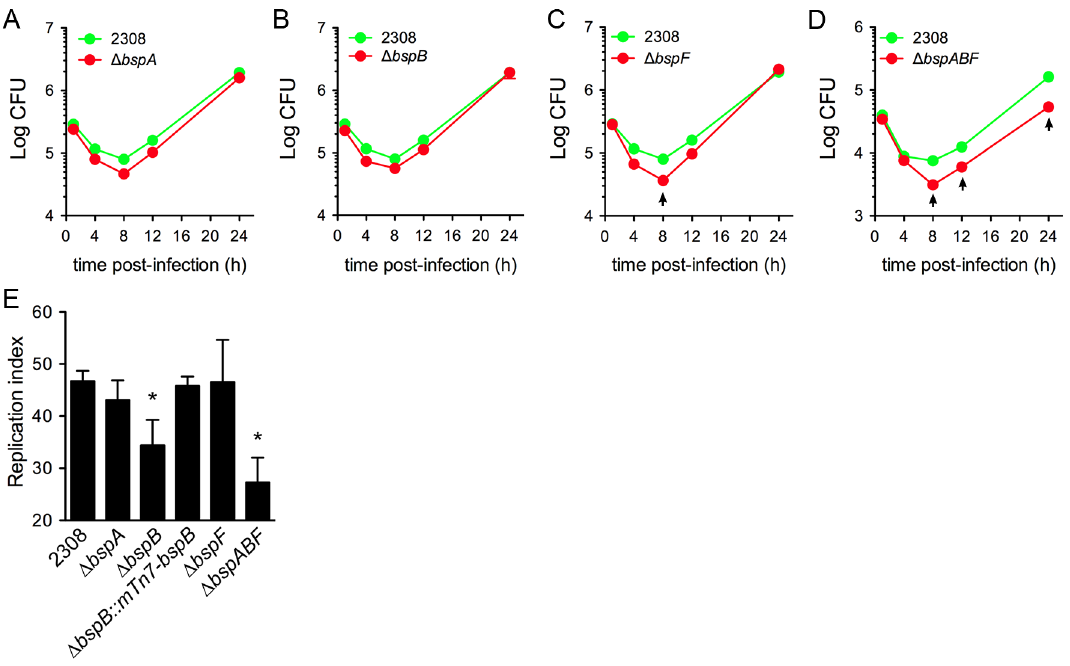
Figure 8. Contribution of BspA, BspB and BspF to Brucella intracellular growth. (A–D) Intracellular growth of B. abortus 2308 and its isogenic in-frame deletion mutants D bspA (A), D bspB (B), D bspF (C) and D bspABF (D) in BMMs. Cells were infected and intracellular CFUs were enumerated at various time points. Data shown are means 6 SEM from a representative experiment performed in triplicates. (E) Single-cell analysis of Brucella replication in BMMs infected with either B. abortus 2308, its isogenic mutants D bspA , D bspB , D bspF and D bspABF or the complemented strain D bspB :: mTn7-bspB . Data is represented as the percentage of infected cells supporting bacterial replication and are means 6 SD of three independent